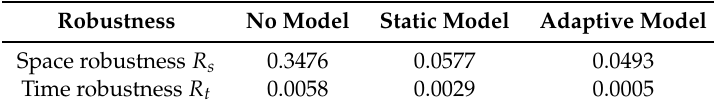
Table 2. Robustness of calibration of the nanopositioning stage.